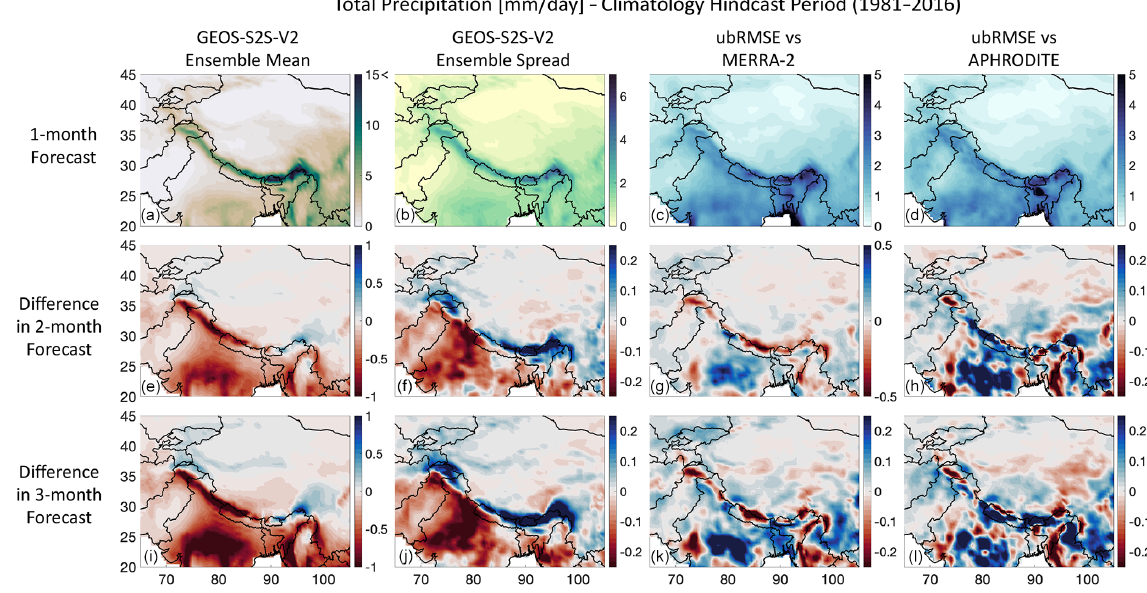
Figure 8. As in Fig. 7, but for precipitation (PRECTOT) in mmd − 1 and vs. APHRODITE in the right column. Here, red in the subfigures indicates lower values (i.e., less precipitation, smaller spread, or smaller error) in the 2- and 3-month forecasts, and blue indicates higher values compared to the 1-month